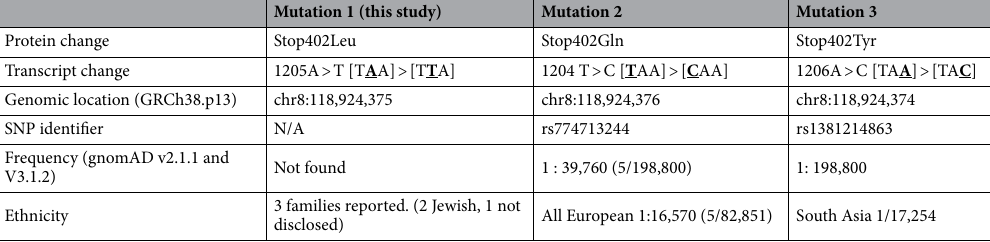
Table I:. Additional stop codon mutations of human OPG